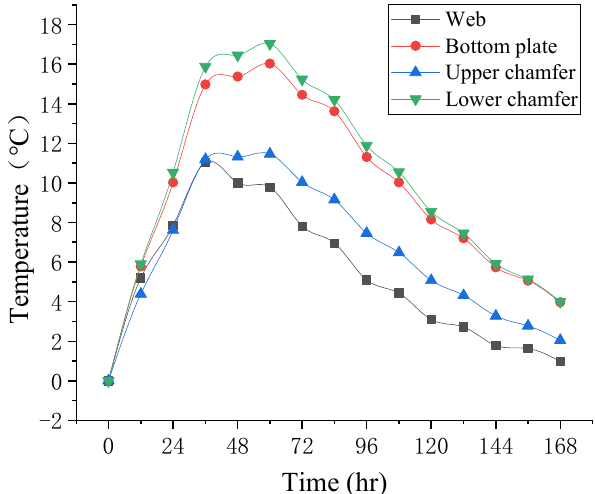
Figure 12. Time–temperature curves between the inside and outside of the box girder.